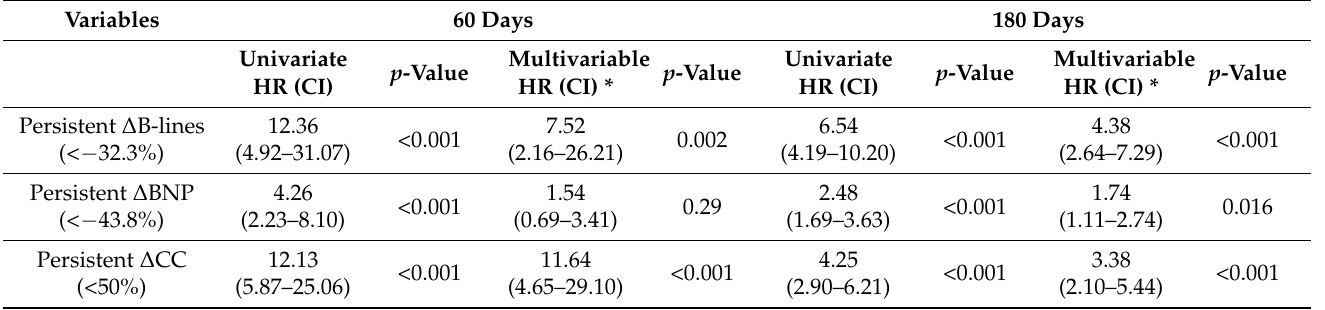
Table 4. Univariate and multivariable analysis for 60 days and 180 days outcome regarding the mean ∆ values of clinical congestion (CC) score, Log BNP and B-lines calculated as the differences between admission and